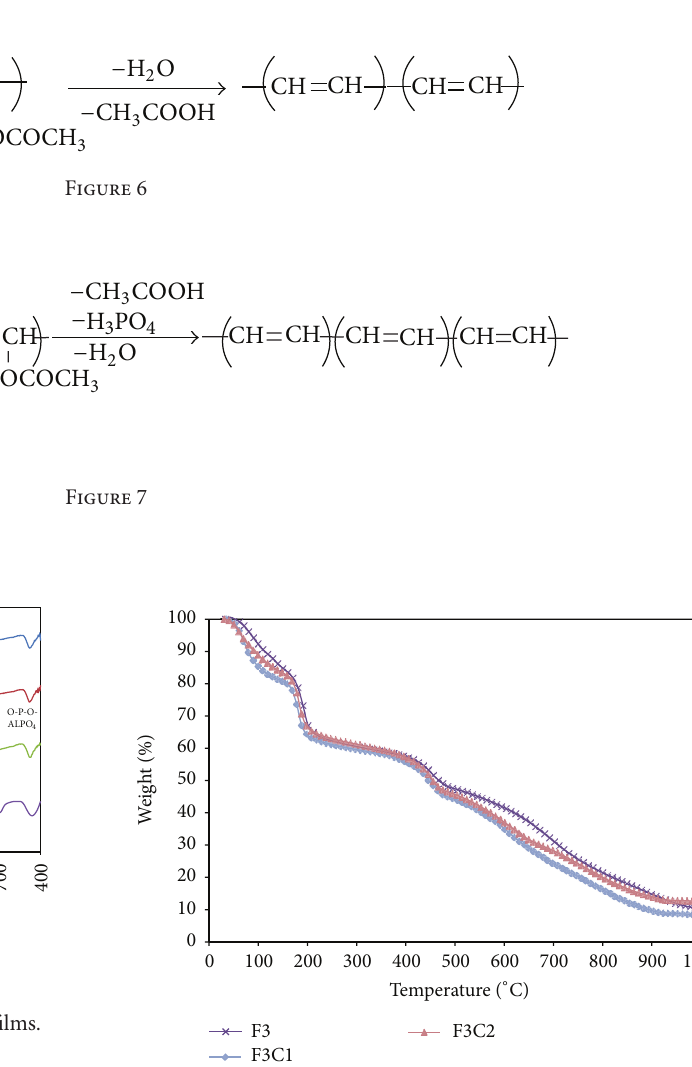
Figure 10: TGA curves for PPVA film (Sample F3) and PPVA- ALPO 4 composite films (Samples F3C1 and